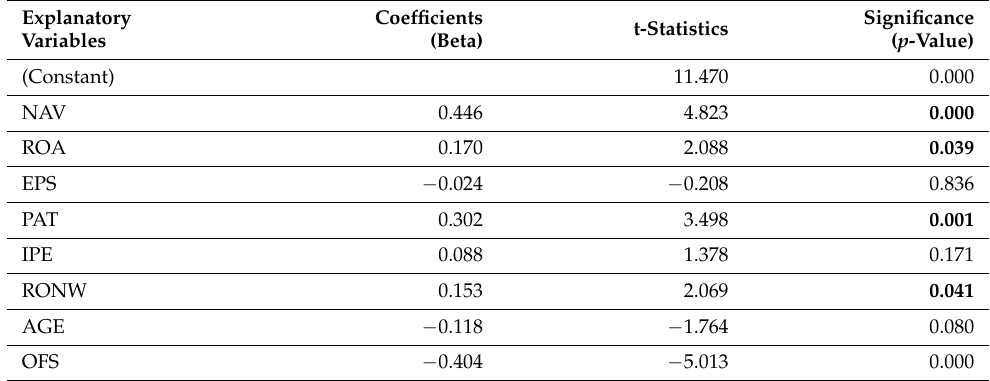
Table 8. Results of Model 3 for Offer Price Regression.